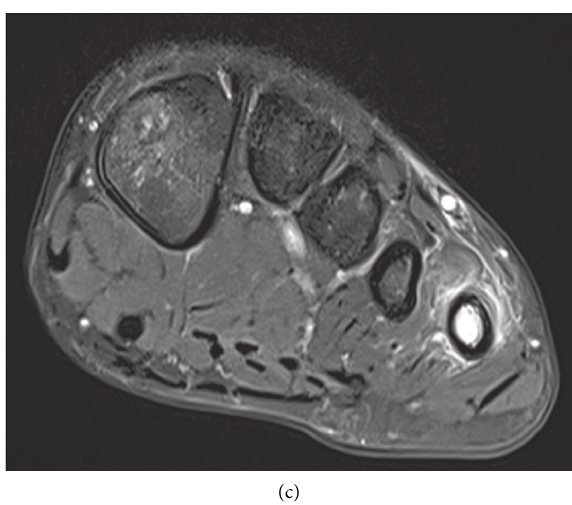
Figure 9: Stress response. Coronal PD (a), coronal (b), and axial PDFS (c) of a 13-year-old soccer player with persistent forefoot pain. There is diffuse marrow oedema signal centred in the 5 th metatarsal shaft with surrounding periosteal and soft tissue oedema. The linear signal at the medial border of the metatarsal shaft represents an incomplete fracture (a,